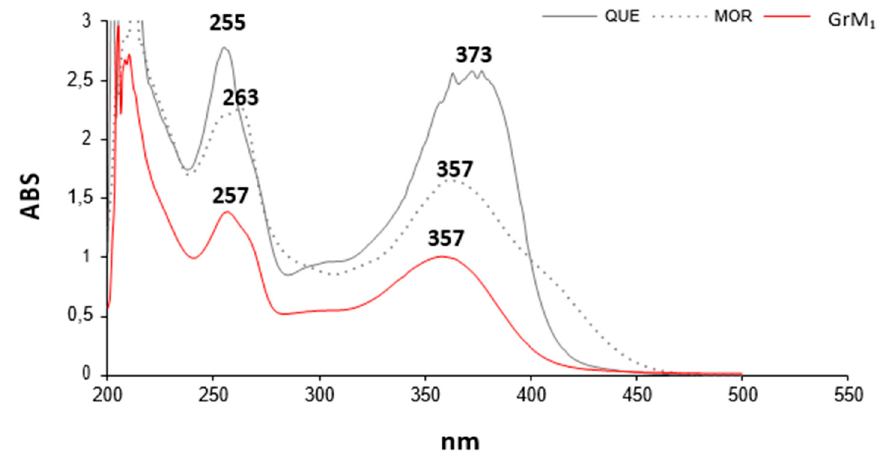
Figure 5. Comparison of the UV–Vis spectra of the metabolite GrM 1 and of quercetin (QUE) and morin (MOR) flavonol isomers.